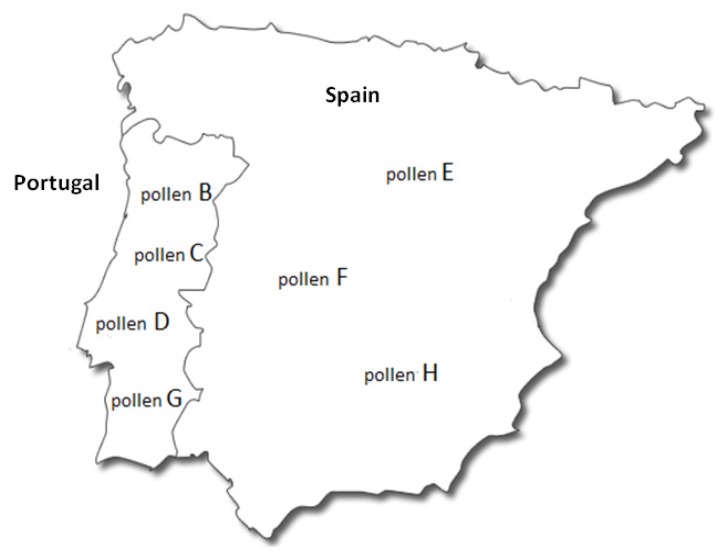
Place of origin of the commercial bee pollen. The origin of Sample A was not specified in the labeling.